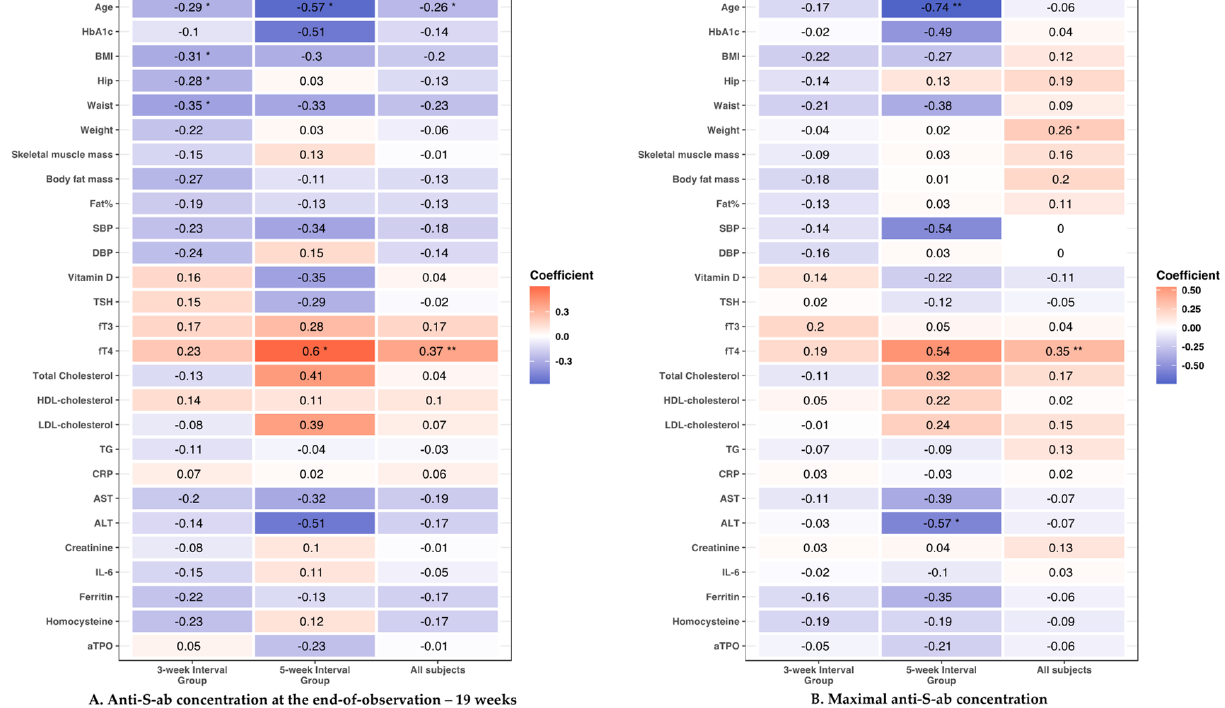
Figure 2. Correlations between clinical parameters and antibody responses ( A ) anti-S-ab concentra- tion at the end-of-observation—19 weeks; ( B ) maximal anti-S-ab concentration). Significance levels: * p < 0.05; ** p < 0.01; Abbreviations: HBA1c—Glycated A1c Fraction of Hemoglobin; BMI—Body Mass Index; Hip—Hip Circumference; Waist—Waist Circumference; SBP—Systolic Blood Pressure; DBP—Diastolic Blood Pressure; TSH—Thyroid Stimulating Hormone; fT3—Free Triiodothyronine; fT4—Free Thyroxine; HDL—High Density Lipoprotein Cholesterol; LDL—Low Density Lipoprotein Cholesterol; TG—Triglycerides; CRP—C-Reactive Protein; AST—Aspartate Aminotransferase; ALT—Alanine Aminotransferase; IL-6—Interleukin-6; Fat%—Body Fat Percentage; aTPO—Anti-